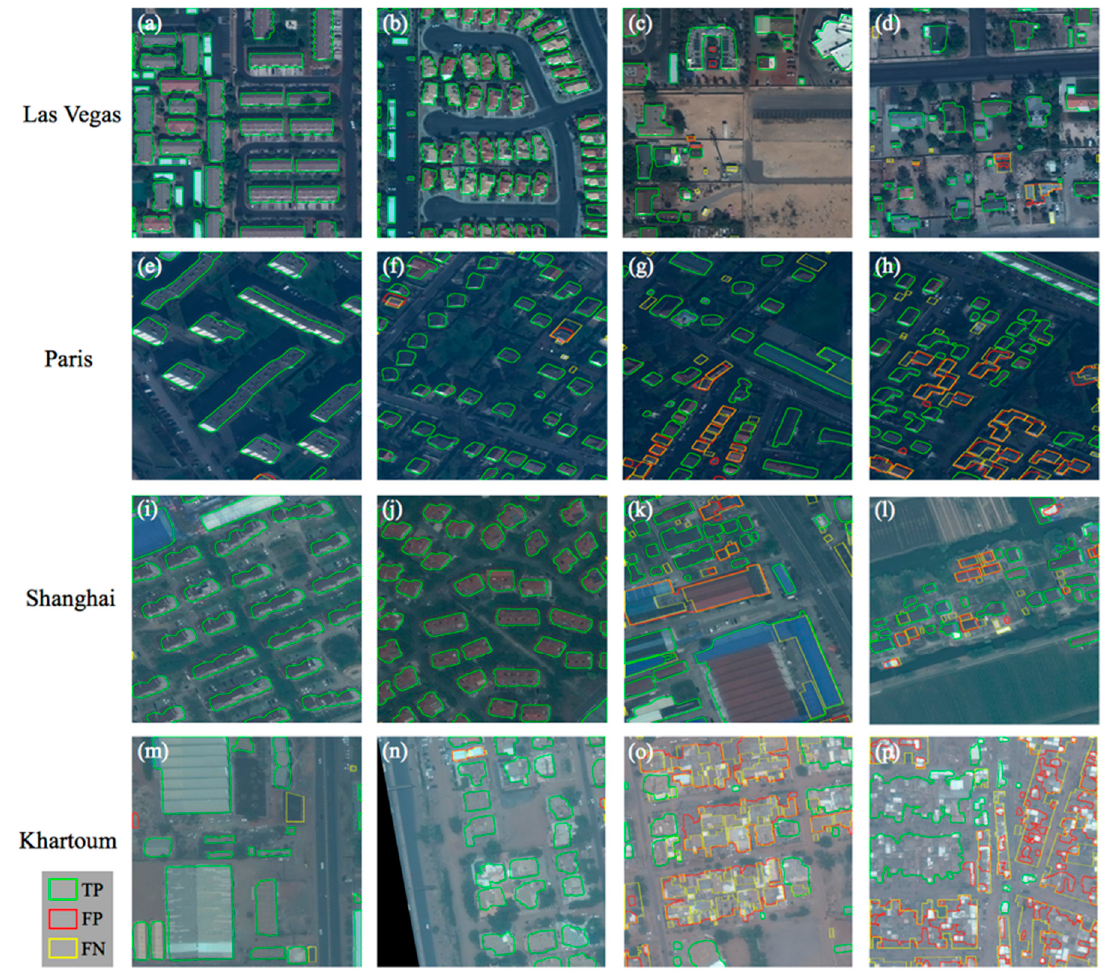
Figure 10. Examples of footprint extraction results obtained from our proposed method in four cities. The two left columns show selected examples with good building extraction results. The two right columns show selected examples with inferior building extraction results.